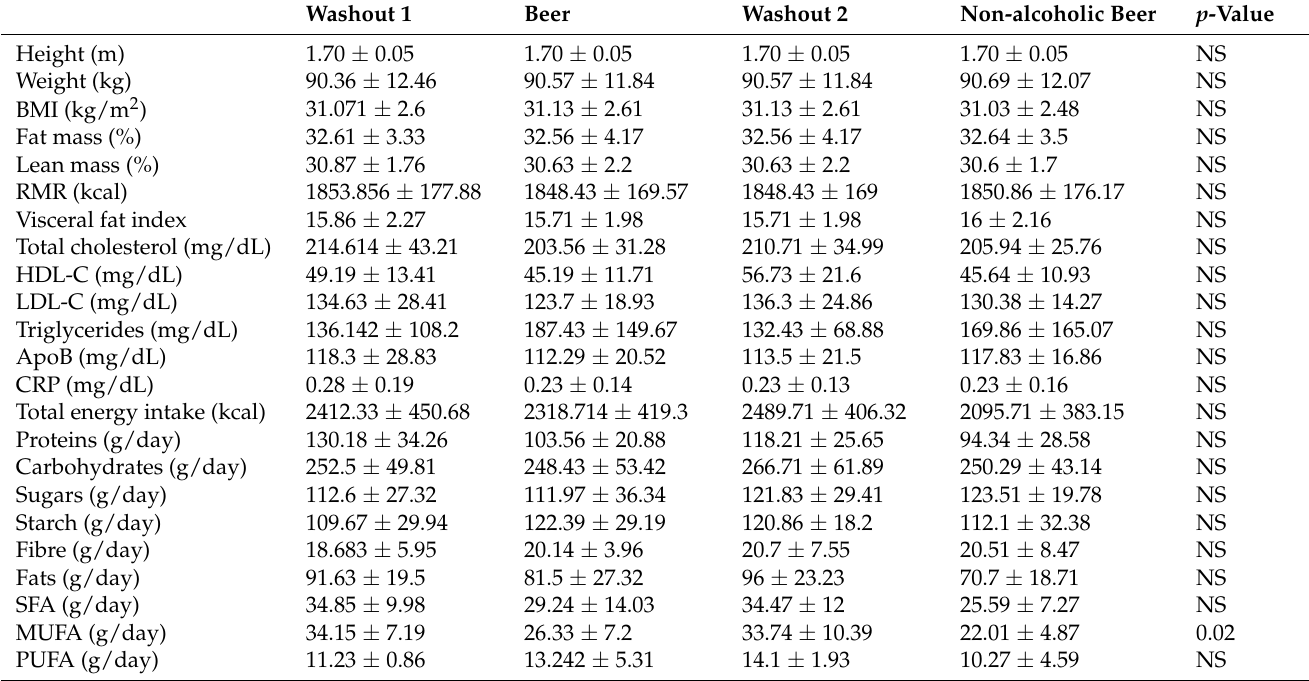
Table 1. Characteristics of participants along the